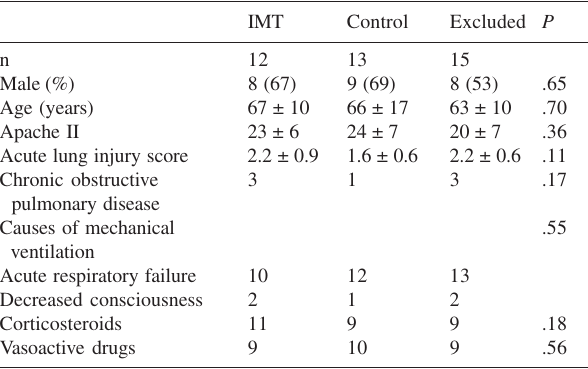
Table 1 - General characteristics of patients at the beginning of the study . Values expressed as mean ± standard deviation